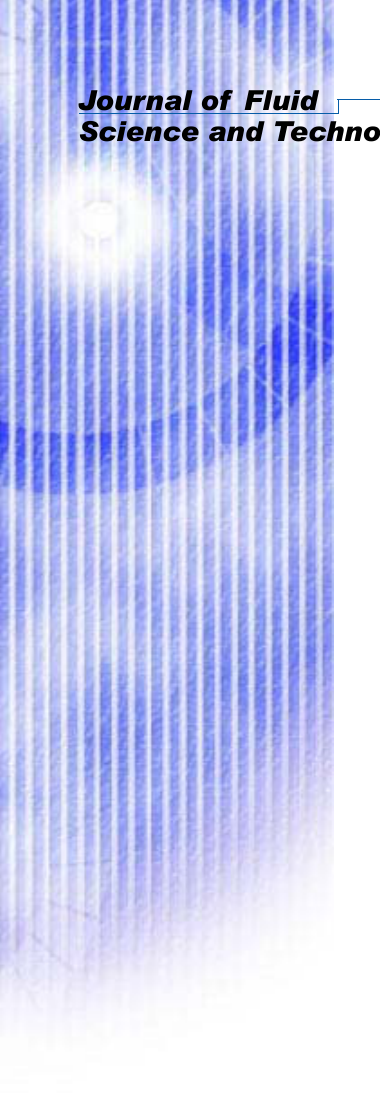
Fig.8 Occurrence regions of unsteady cavitation in the cases of s =0mm, 20mm and 30mm for